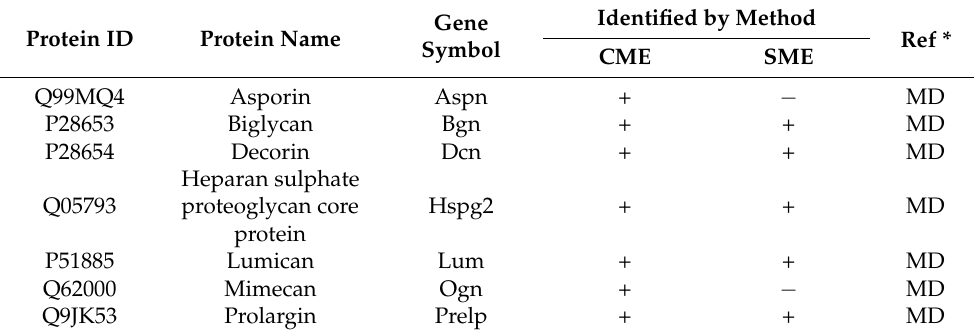
Table A3. The list of core matrisome proteins belonging to the category of proteoglycans and identified in at least two of the biological